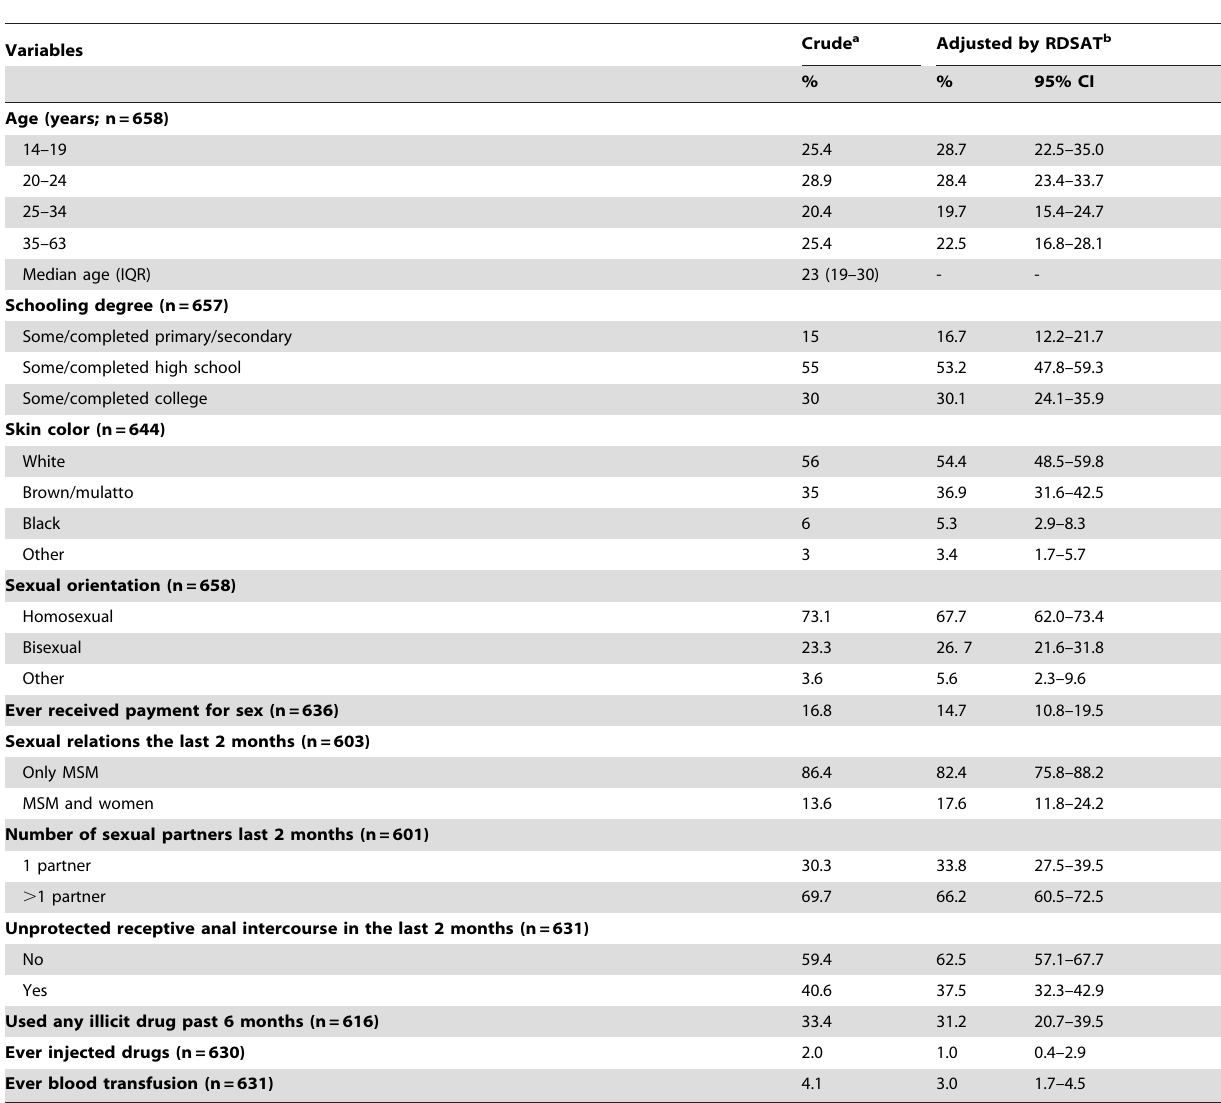
Table 1. Sociodemographic characteristics of the studied MSM